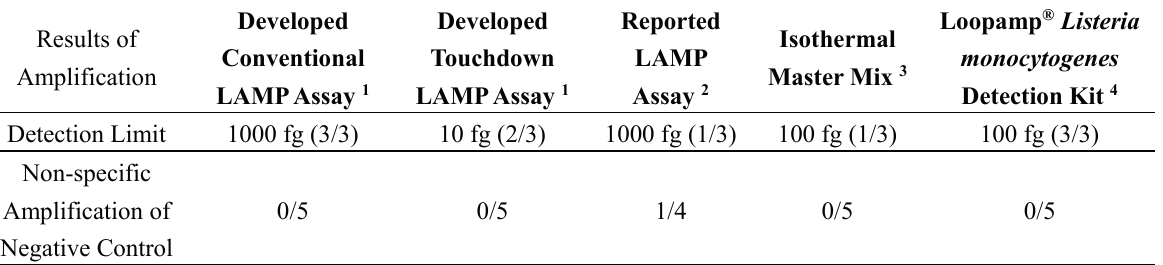
Table 3. Sensitivity determination with different LAMP